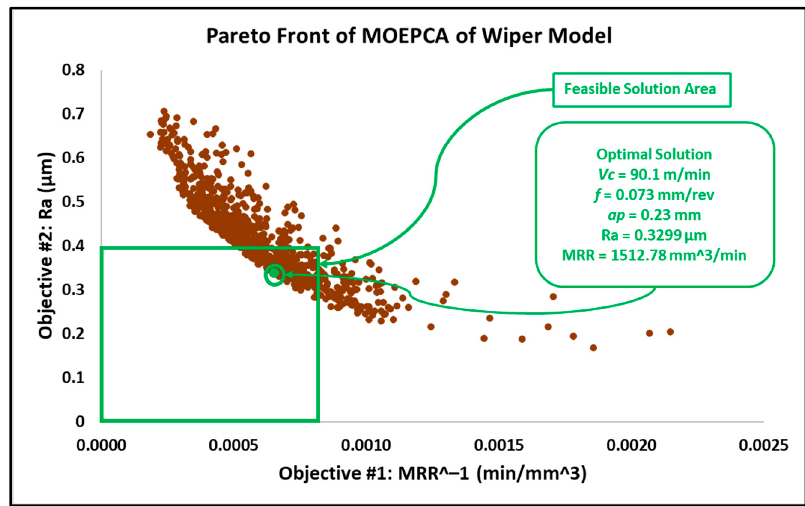
Figure 10. Pareto front plot of MOEPCA solution of the wiper model.